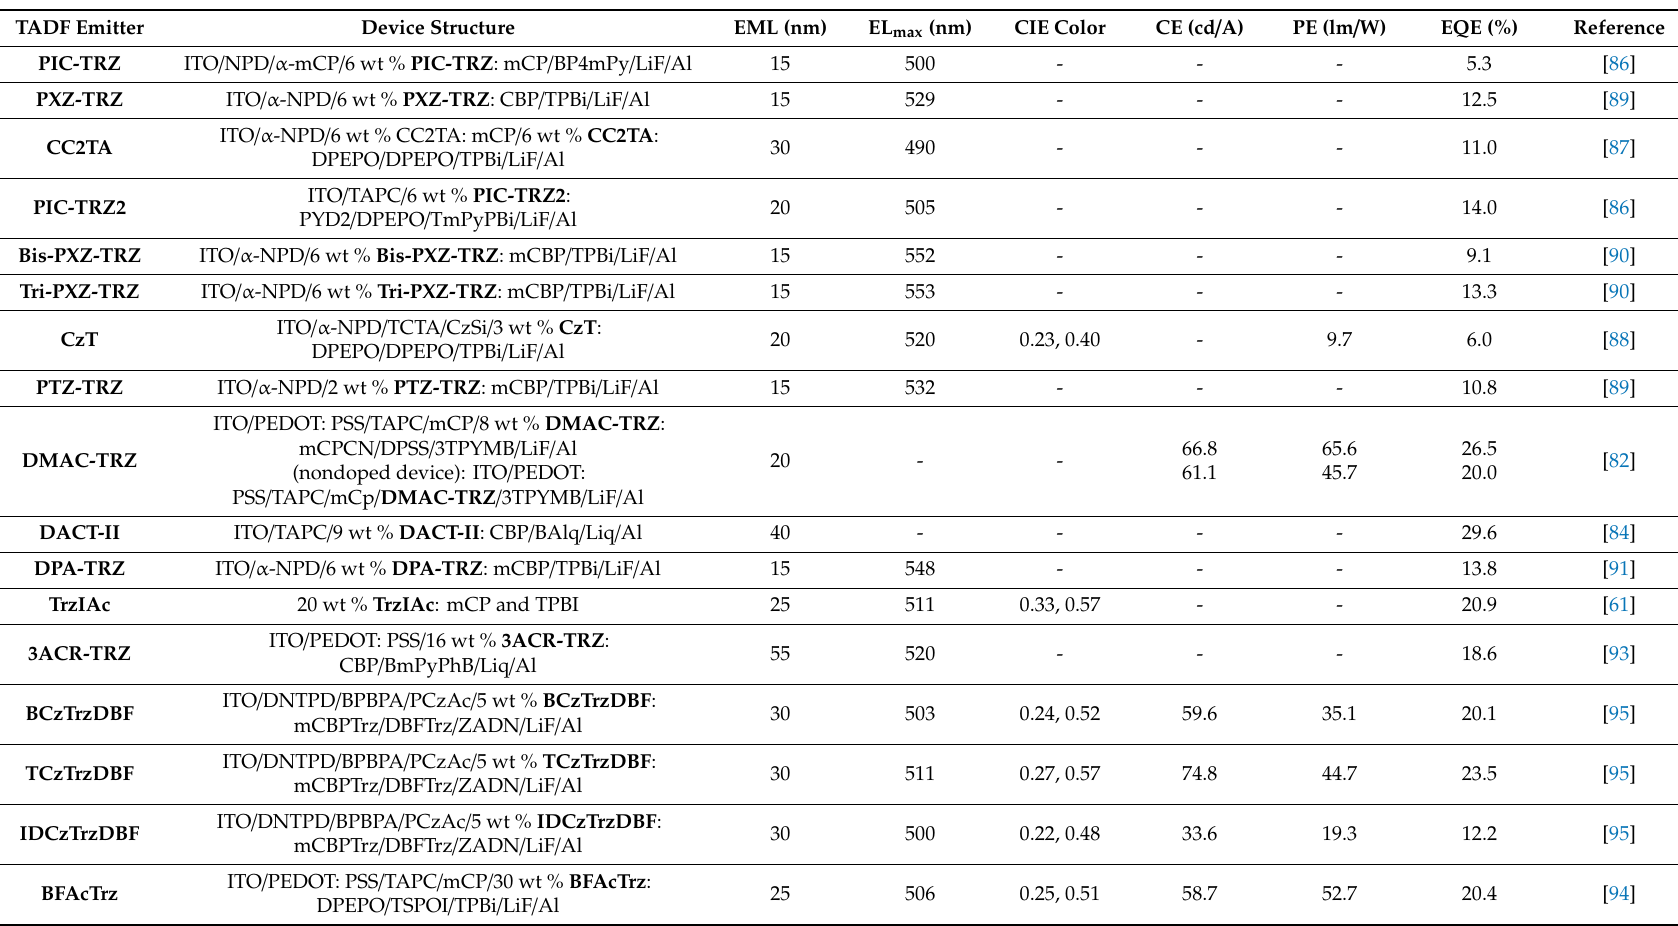
Table 2. Organic light-emitting diodes (OLED) device evaluation performances of triazine-based green TADF